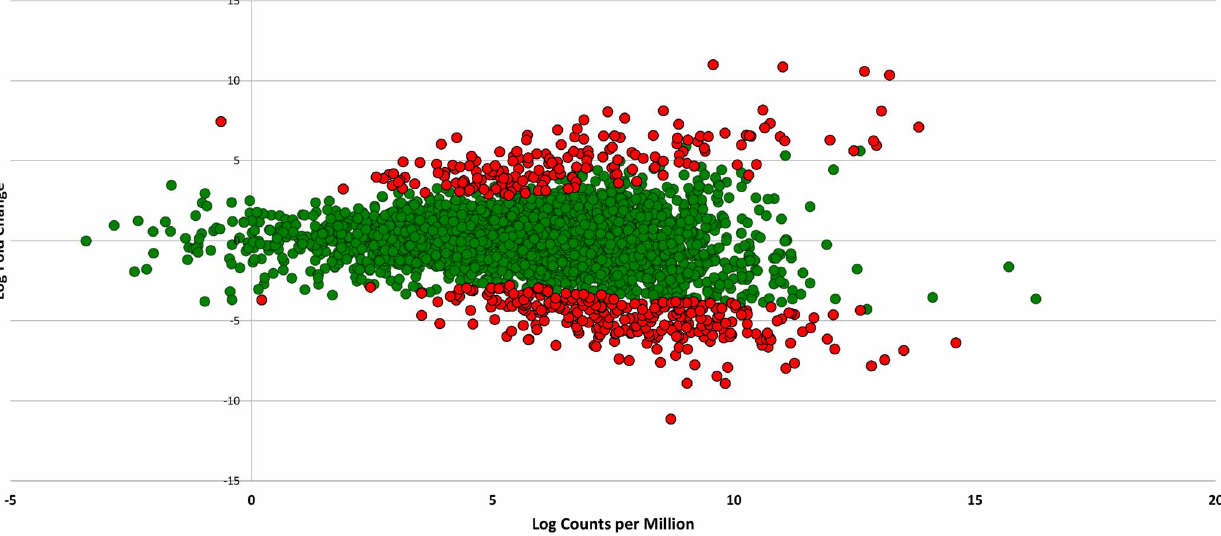
Fig. 1. Smear plot of differentially expressed genes in V. vulnificus CMCP6 exposed to human serum (relative to artificial seawater). The smear plot shows the relationship between the log fold change and log counts per million. Green points represent non-significant DE genes whereas red points show genes that are significantly differentially expressed (p , 0.0001) in relation to artificial